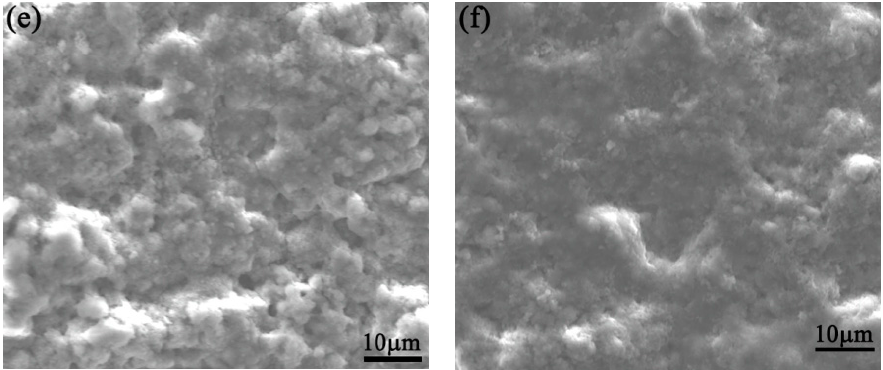
Figure 4. SEM morphologies of the tested Q345 steel after different immersion durations: ( a ) 24h; ( b ) 72 h; ( c ) 168h; ( d ) 288 h; ( e ) 432 h; and ( f ) 600 h.